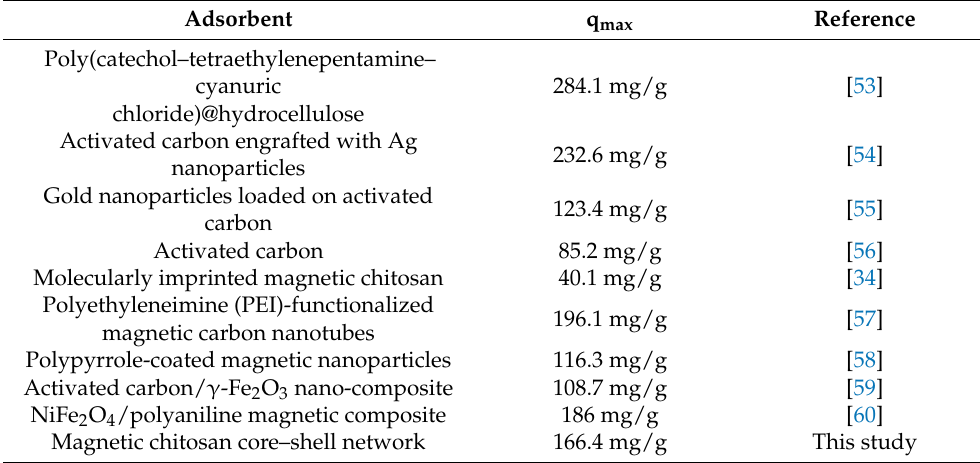
Table 2. Comparison of maximum adsorption capacity (q max ) for ARS dye removal with other adsorbents.